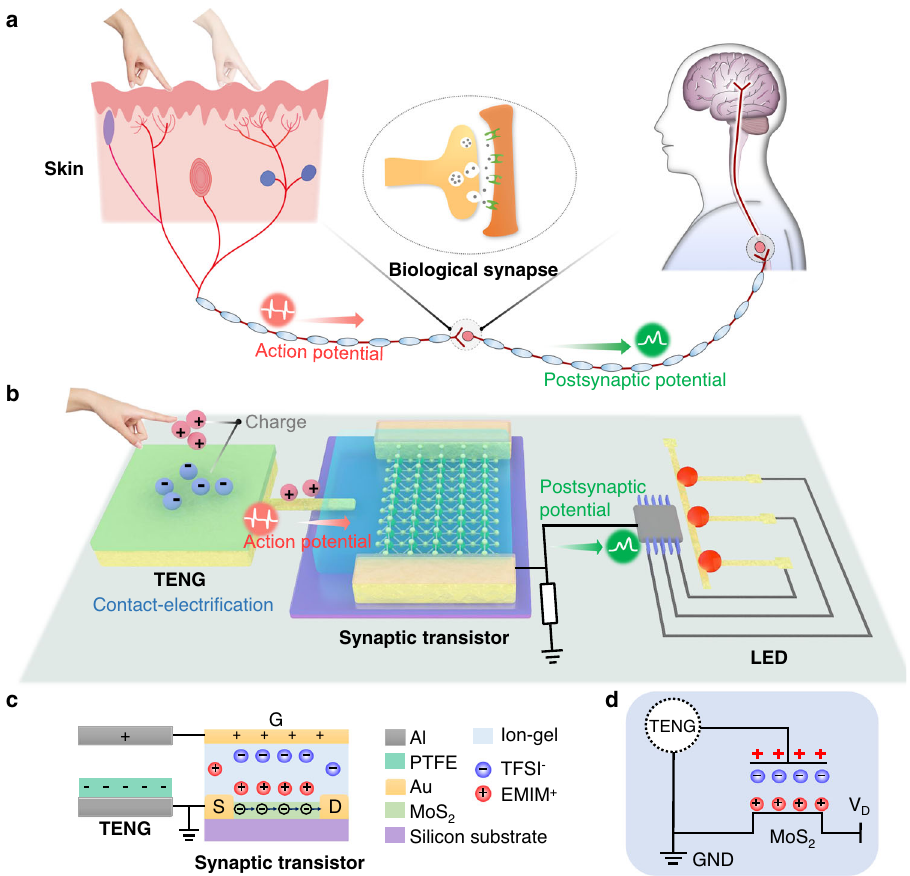
Fig. 1 Biological afferent nerve system and CE-activated arti fi cial afferents. a The basic procedure of the postsynaptic current activated by external stimulation in the biological afferent nerve system. The external stimulation initiates an action potential in the sensory neuron. The action potential propagates along with the nerve fi ber and leads to a potential change in the adjacent nerve cell (i.e., activating postsynaptic current). b Schematic illustration of the CE-activated arti fi cial afferent. It includes a self-activation component, a synaptic transistor, and a functional circuit. c Cross-sectional view of the CE-activated MoS 2 synaptic transistor and illustration for each component. d Circuit diagram of the CE-activated arti fi cial